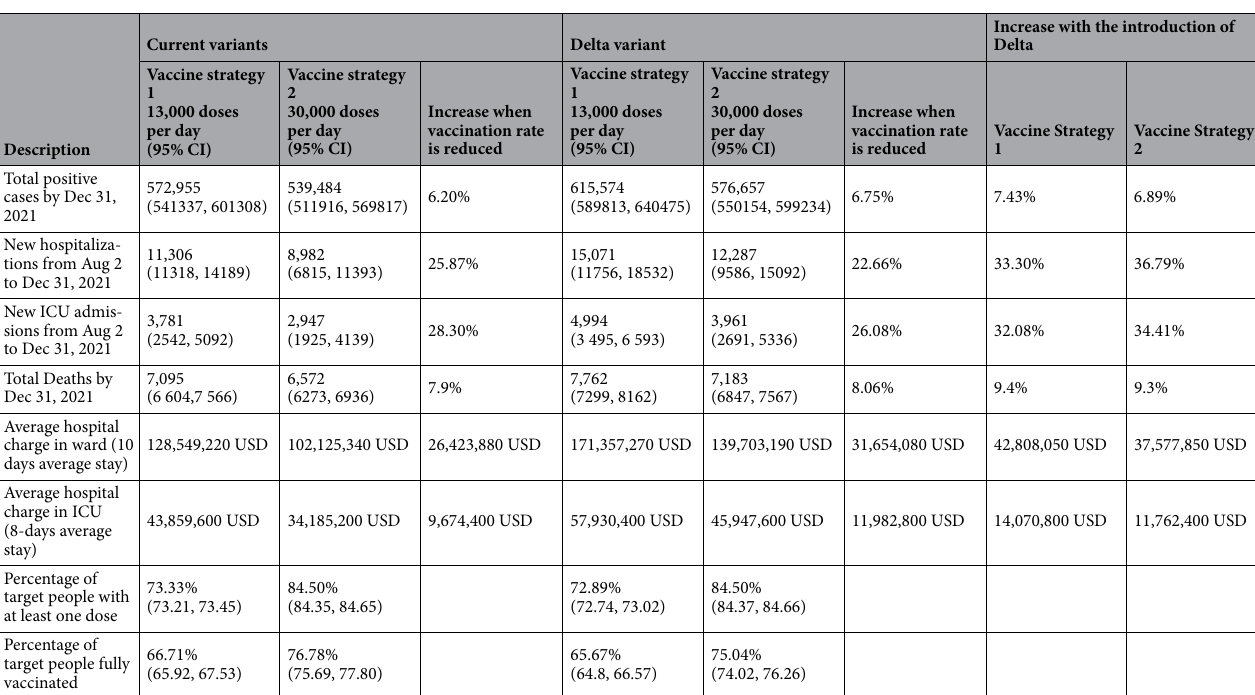
Table 2. Summary of results. The values and percentages correspond to the results of two vaccine strategies with and without introducing the Delta variant in Costa Rica, a country with five million inhabitants. Hospital expenses are calculated based on a stay of 10 days in the medical ward and eight days in the ICU with an average cost per day of 707,540 colones (about 1,137 USD) in the medical ward and 902,641 colones (about 1,450 USD) in the